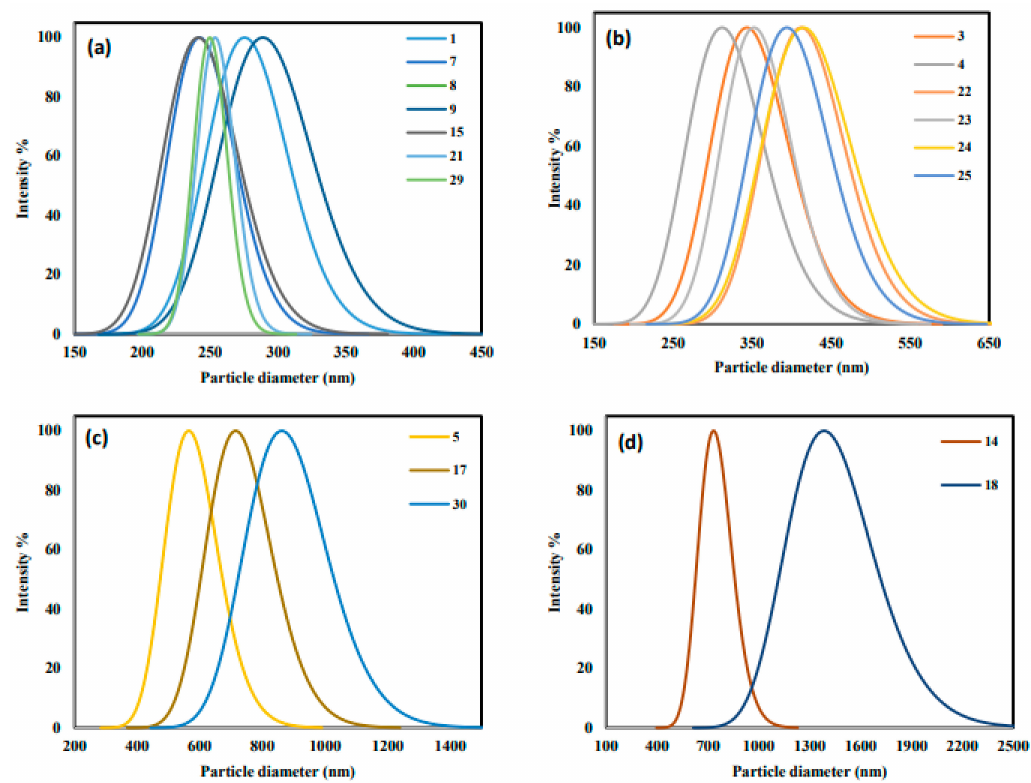
Figure 3. ZnO particle size distribution obtained from dynamic light scattering (DLS) for samples 1, 7, 8, 9, 15, 21, and 21 ( a ), samples 3, 4, and 22–25 ( b ), samples 5, 7, and 30 ( c ), samples 8 and 14 ( d ). Details of each sample synthesis conditions can be found in Table